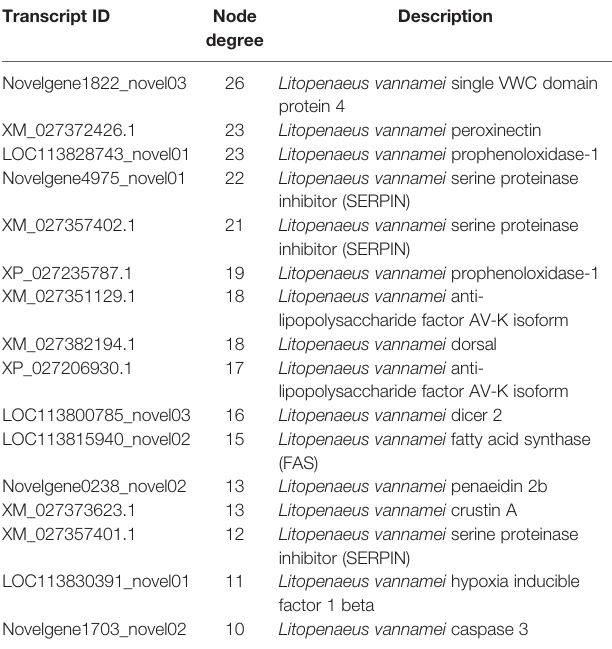
TABLE 3 | The transcript hubs (nodes with the most degrees) information of the correlation network.